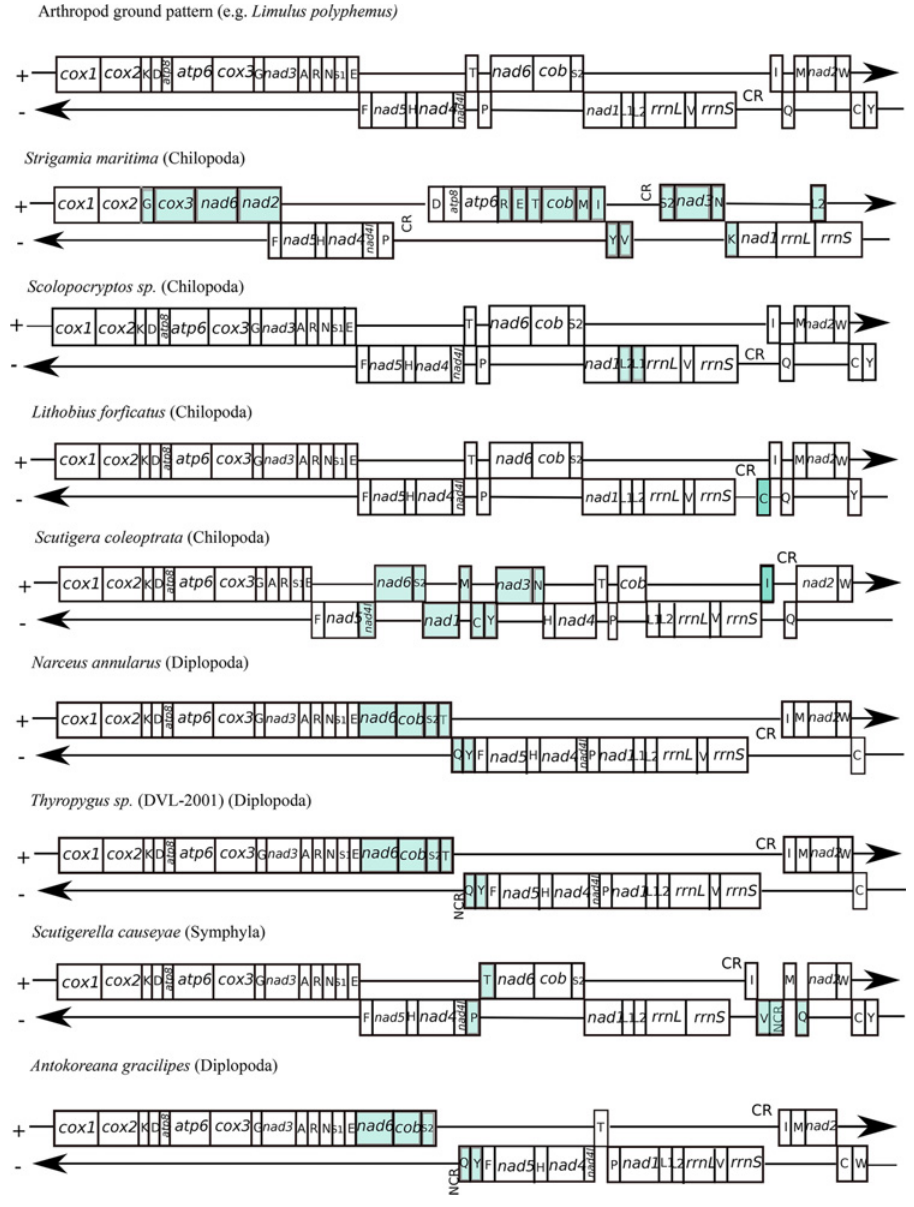
Fig 3. Comparisons of gene orders in the mitochondrial genomes of Strigamia maritima , the arthropod ‘ ground-plan ’ ( Limulus polyphemus ), three further chilopods, three diplopods and a symphylan. Genes are not drawn to scale; shaded genes indicate those that have moved from the original arthropod ‘ ground-plan ’